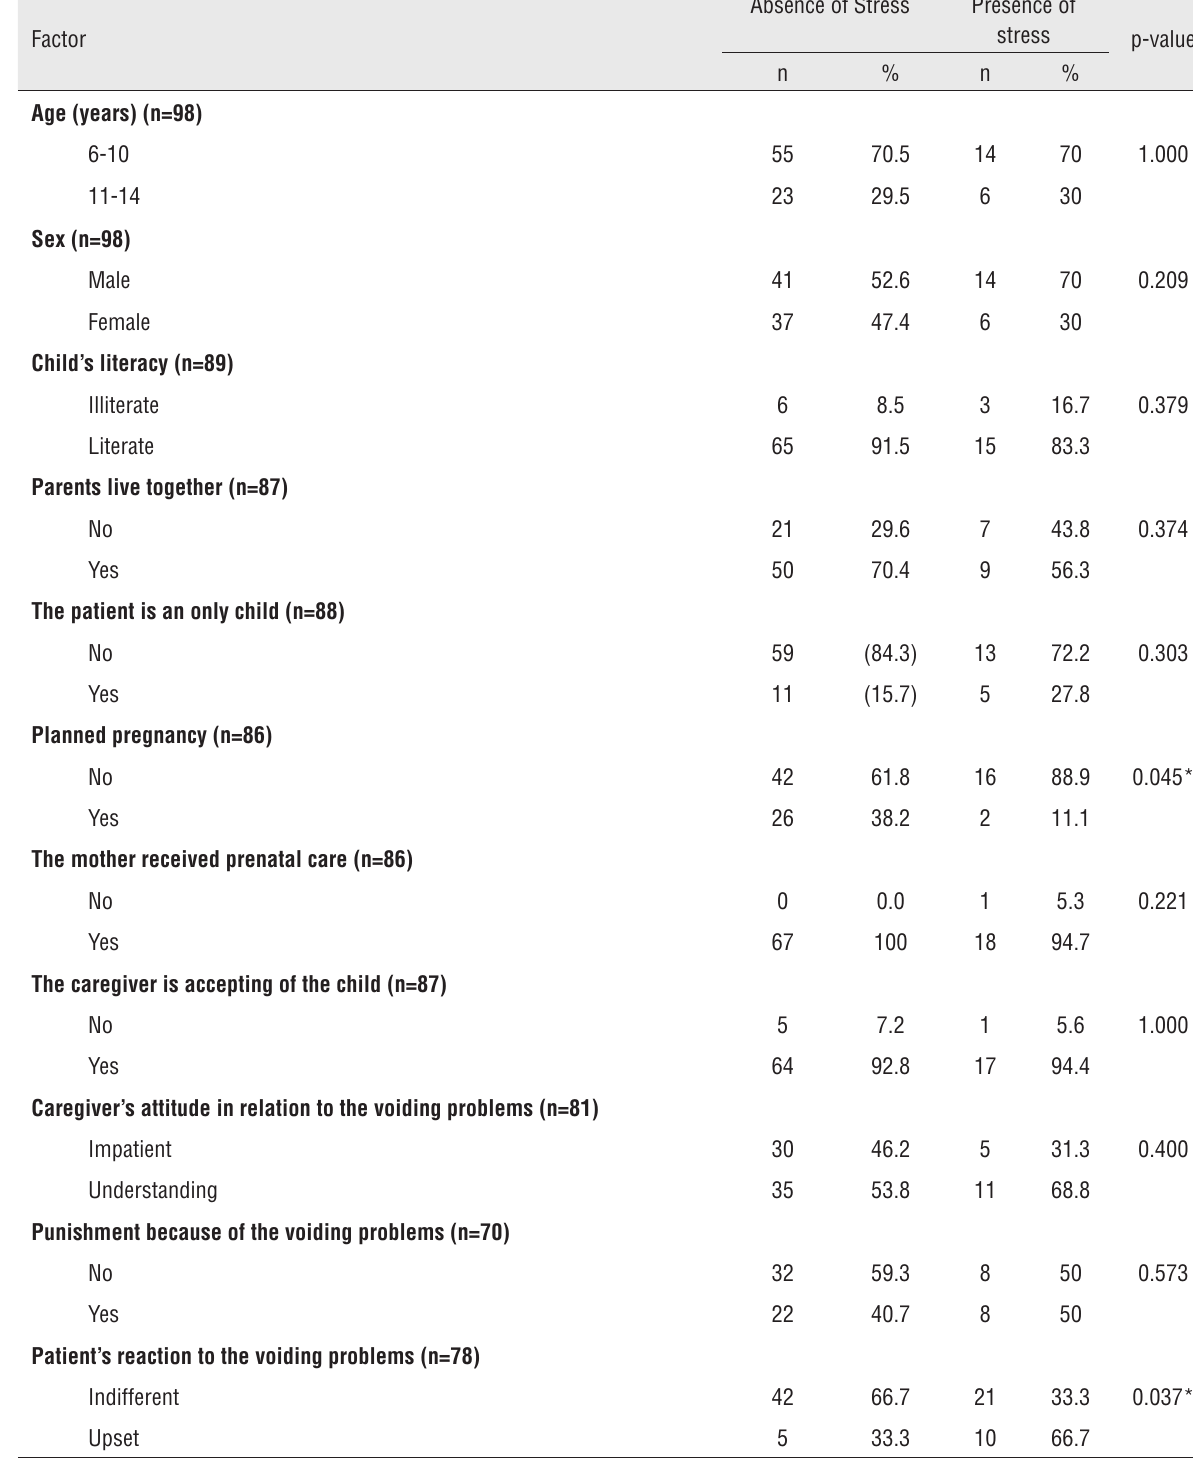
Table 2 - Associations between the characteristics of the children/adolescents and the results of the Child Stress Scale. Factor